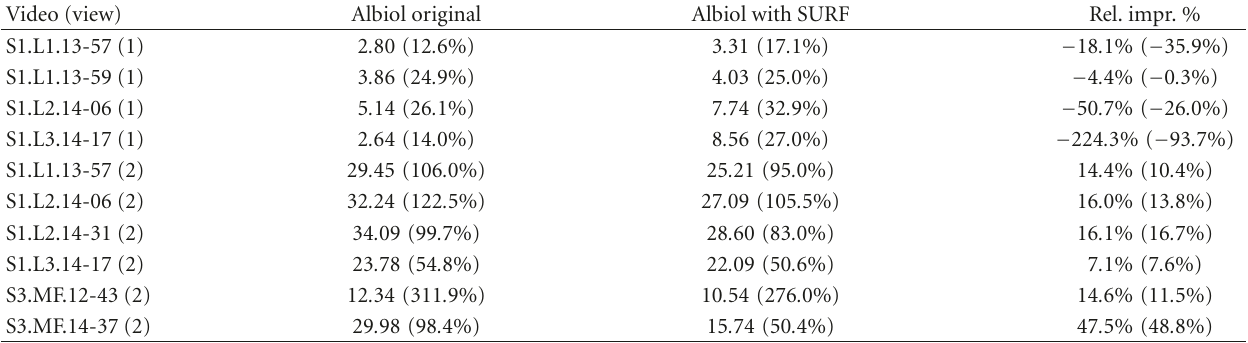
Table 3: Performance obtained by the method of Albiol et al. when the original implementation is used or when the SURF points are adopted. Video (view) Albiol